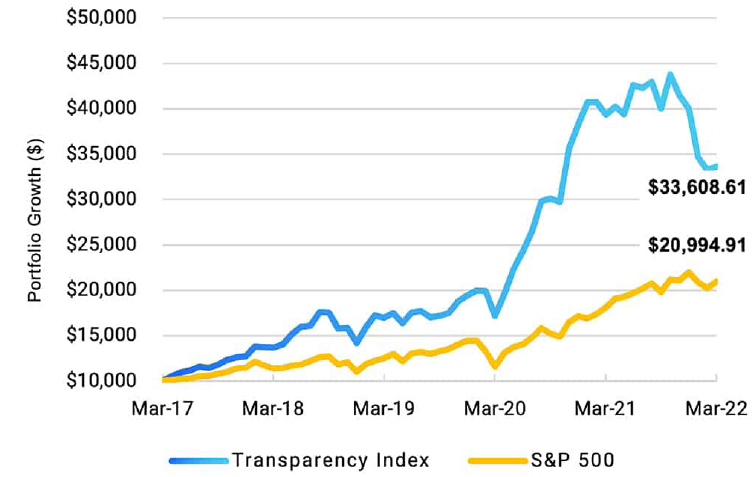
Figure 2. Dynamics of changes in the transparency index and the value of the portfolio of the 100 most informationally transparent companies in the